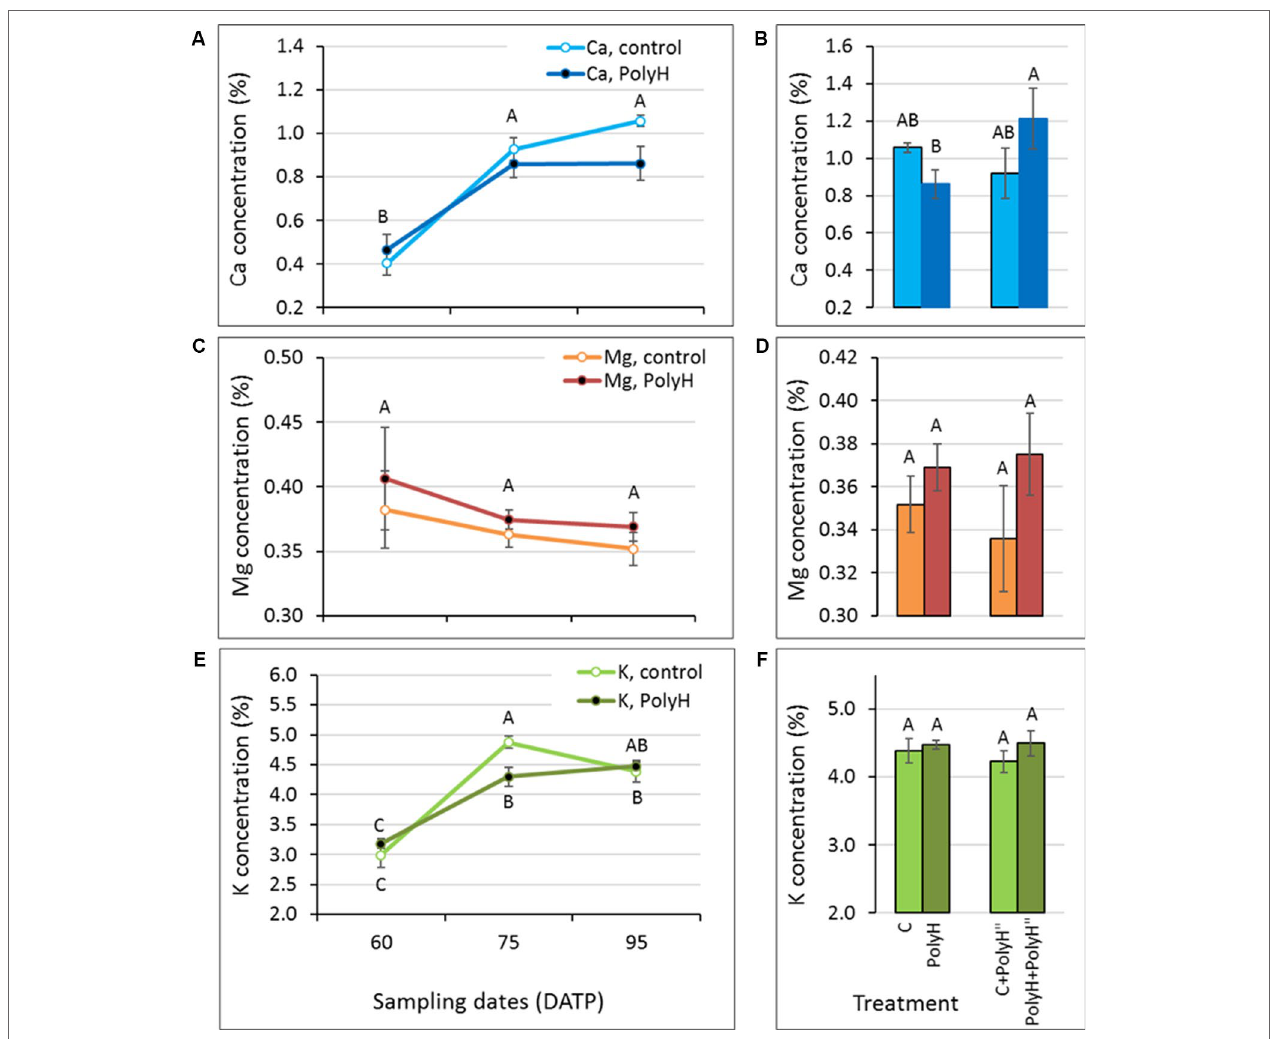
FIgURE 5 | Ca, Mg, and K concentrations in the peels of early- and late-bulking Rosanna tubers following polyhalite fertilization (experiment 3). (a , C , E) Potato plants were fertilized with polyhalite preplanting (PolyH); control plants (C) were not fertilized. Tuber peel was collected at 60, 75, and 95 DATP. (B , D , F) Late in-season application of polyhalite (PolyH") was performed at 85 DATP for both PolyH plants (PolyH+PolyH") and their controls (C+PolyH"). Peel samples were collected at 95 DATP together with the PolyH and C samples. Bar charts compare mineral elements concentrations in tuber peel collected at 95 DATP following polyhalite application at preplanting and polyhalite application in-season. Mineral elements concentrations are given as percentage of peel dry weight. (a , B) refer to Ca, (C , D) to Mg, and (E , F) to K concentration. Values are averages of five replicates with SE. Two-factor analysis—time and treatment—was performed with data of charts (a , C) , and (E) . Interaction was found only for K concentrations. For Ca and Mg, different letters indicate significant difference by Student’s t -test ( P < 0.05) between time points, with no difference between treatments. Data of charts (B , D) , and (F) were analyzed for statistical significance as one variable (treatment) by Student’s t -test; different letters indicate significantly different values ( P <